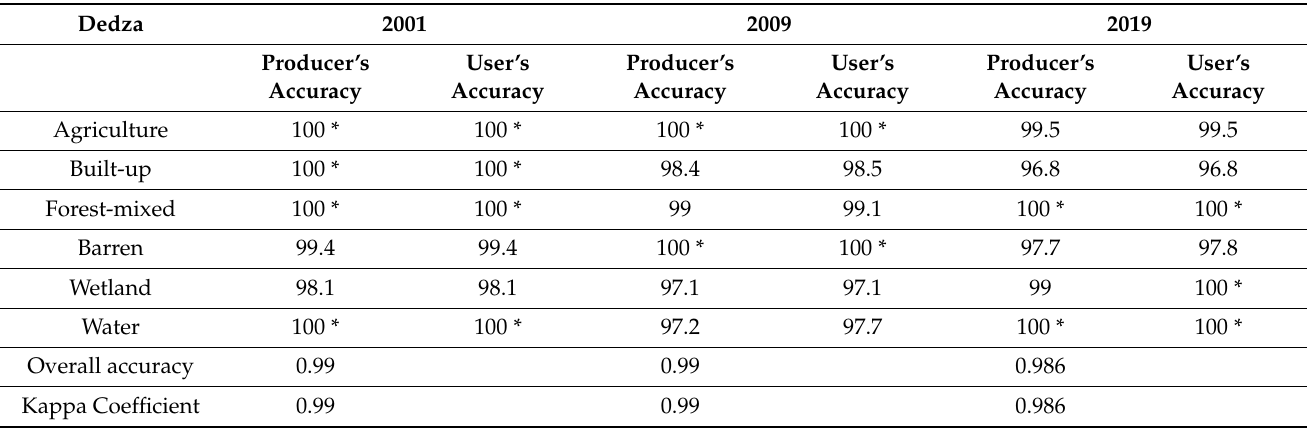
Table 6. Accuracy assessment summary for classified land-cover maps for Dedza district. (* accuracy value of 100 has been rounded).